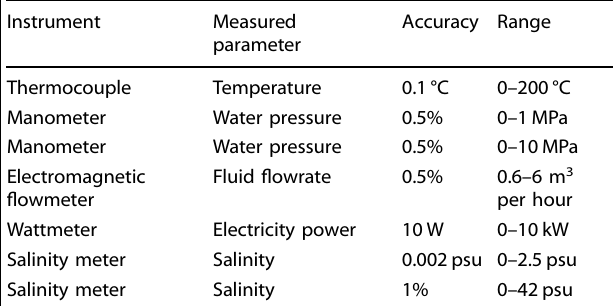
Table 4. Instruments with accuracy, range, and standard